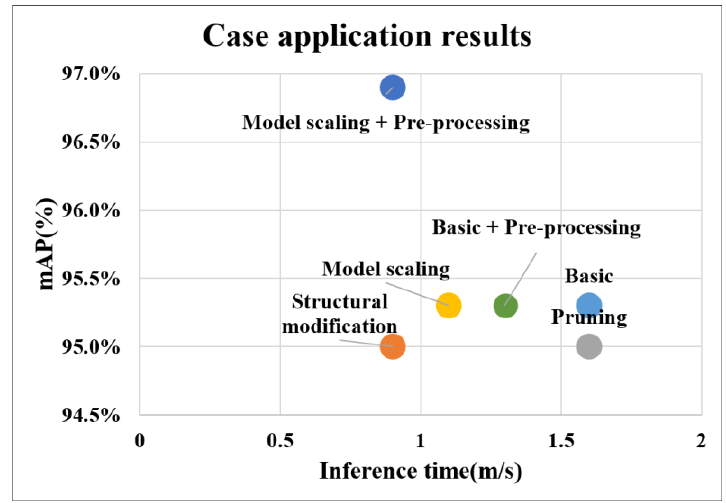
Figure 18. Final result analysis graph. Table 7. mAP analysis (model scaling and pre-processing).